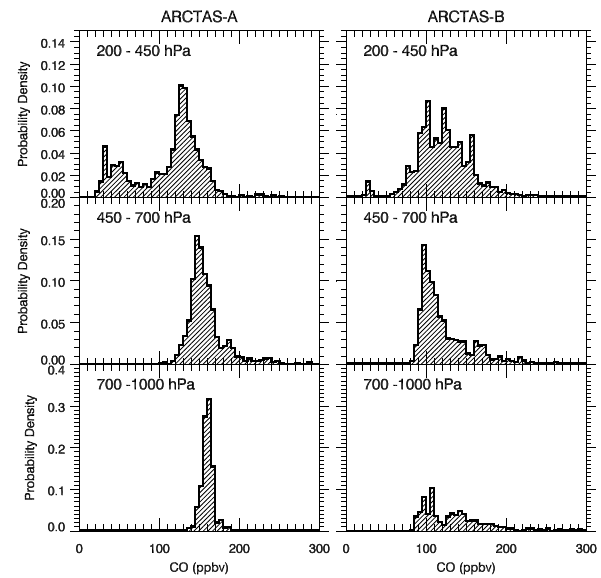
Fig. 2. The probability distribution function (PDF) of observed CO along DC-8 flight tracks for ARCTAS-A (left column) and ARCTAS-B (right